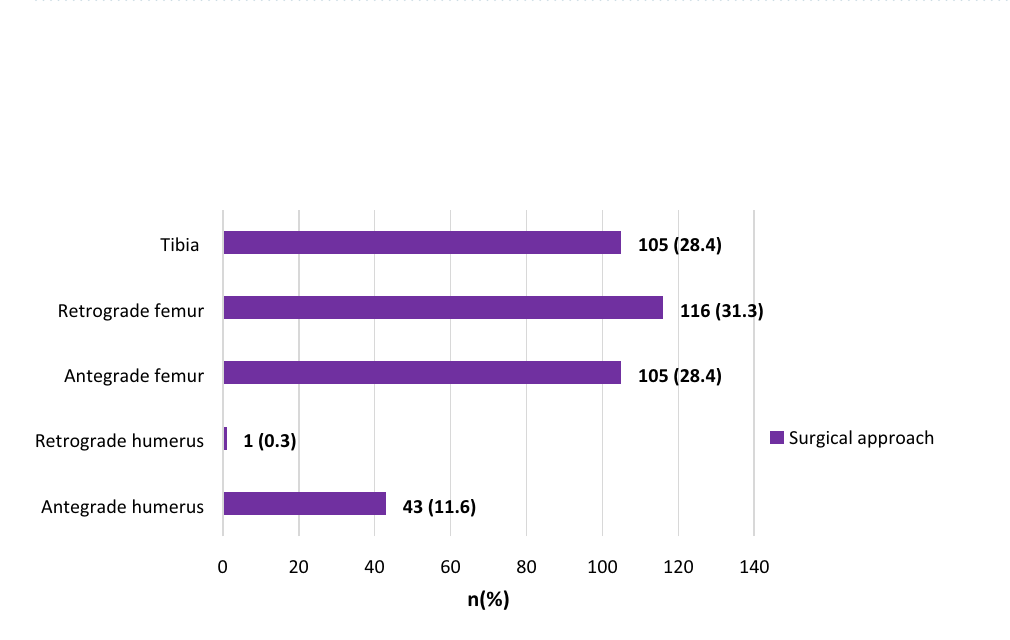
Table 2. Fracture morphology (OA/OTA Classification).